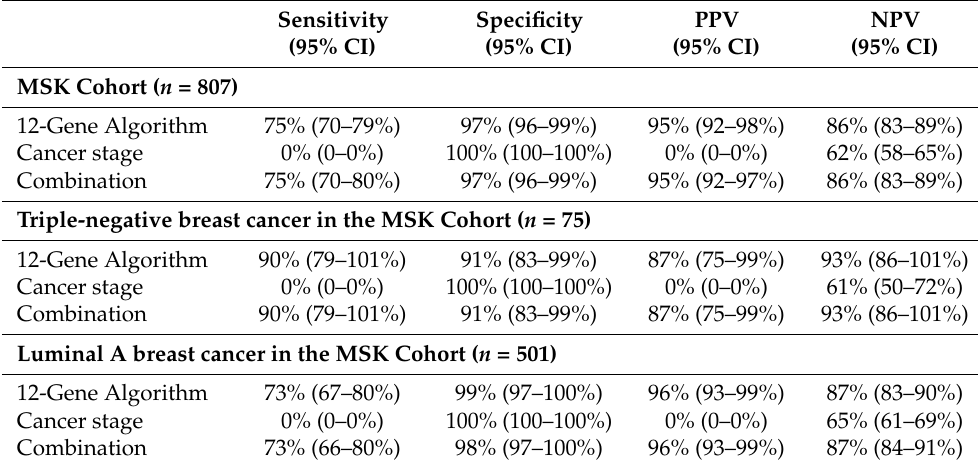
Table 4. Accuracy of the 12-Gene Algorithm and cancer stage for distinguishing progression and non-progression after treatment in the MSK Cohort ( n = 807), triple-negative subgroup ( n = 75), and luminal A subgroups ( n =